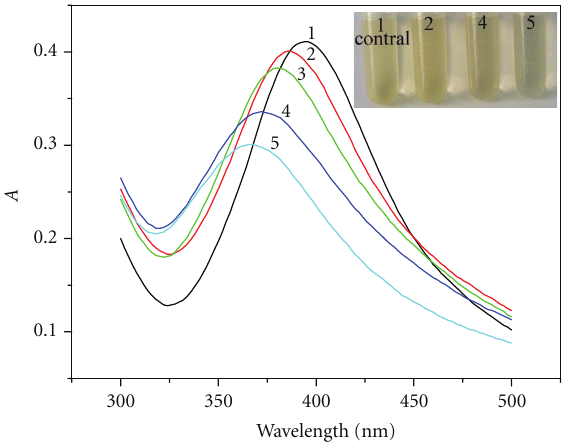
Figure 1: The absorption spectrum of AgNPs in the absence and presence of Hg (II) ion. (The inset picture displays color change corresponding to the curves: the solution color gradually changed from yellow to colorless.) Concentration: AgNPs: 6.5 × 10 − 5 mol/L; Hg (II) ion (from 1 curve to 5, × 10 − 6 mol/L): 0, 1.2, 3.2, 4.8, 6.0; HAc-NaAc bu ff er (pH